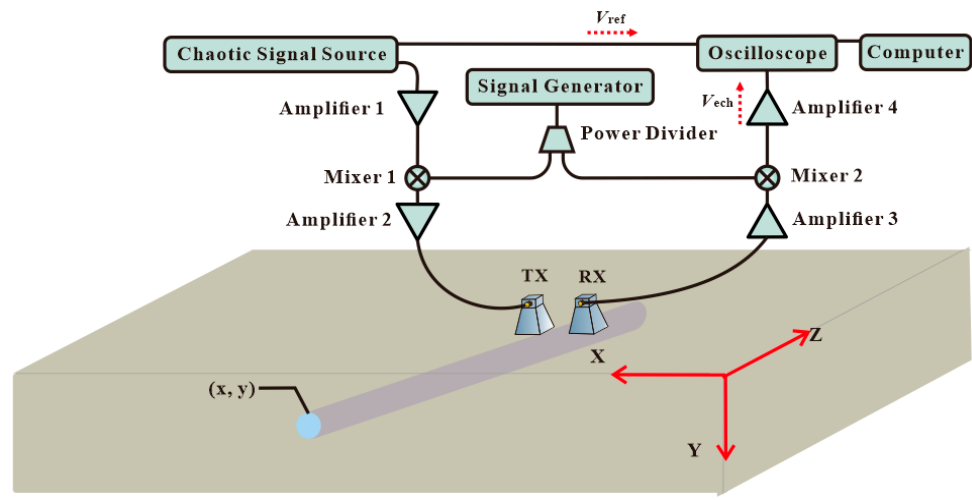
Figure 1. Block diagram of the chaotic radar system.